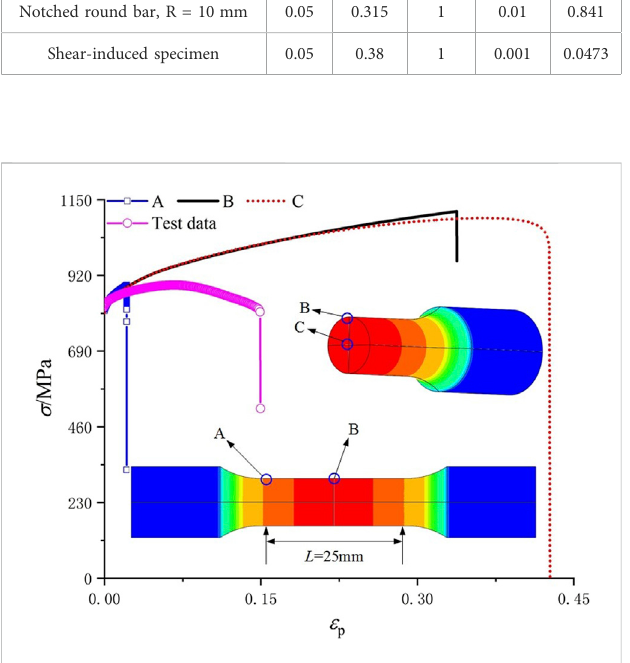
FIGURE 6 Stress versus plastic strain for smooth round bar.